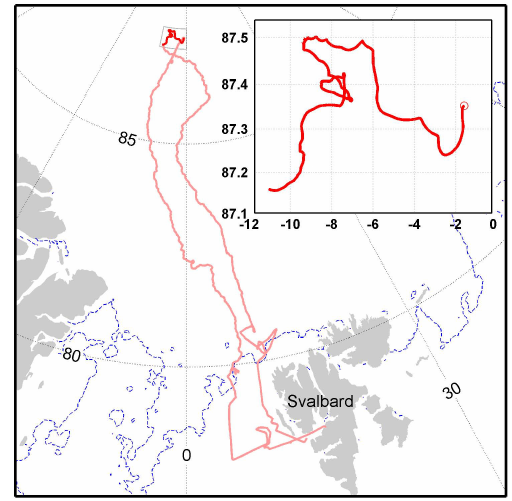
Fig. 1. Cruise and drift (inset) track of Oden during ASCOS. The sea-ice edge is denoted by the blue